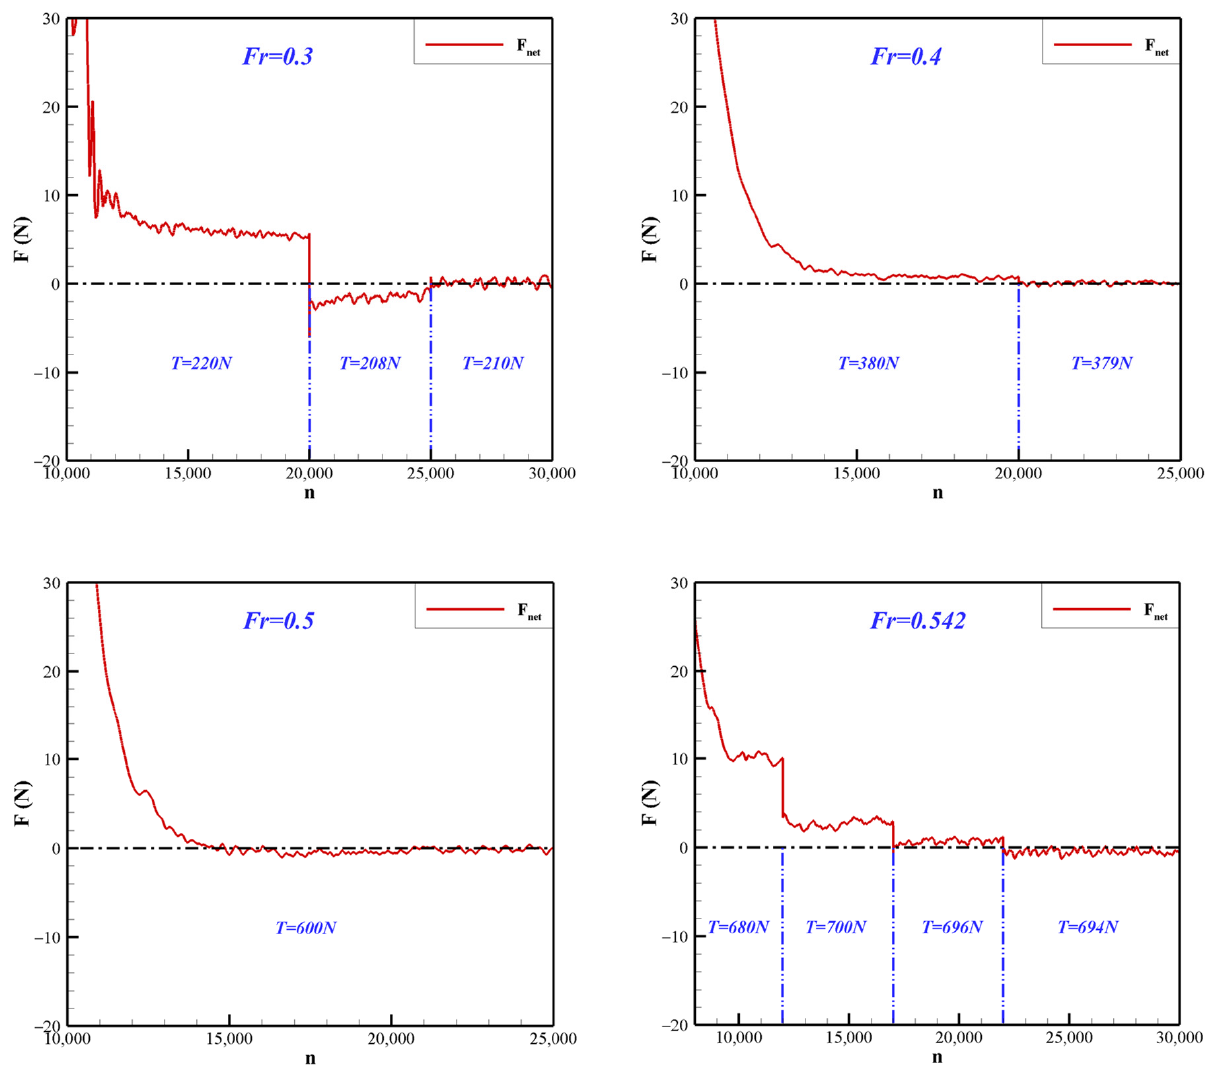
Figure 10. Convergence history of the net force F net of waterjet-propelled ship with the body-force model.